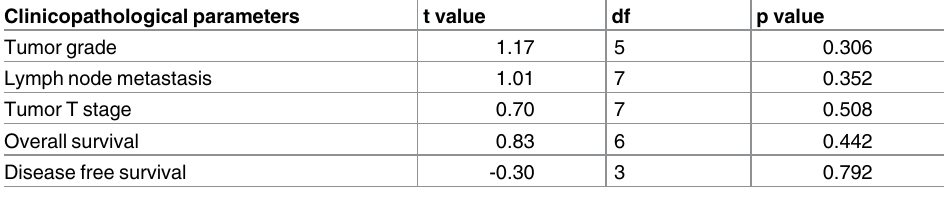
Table 2. Egger’s test of funnel plot